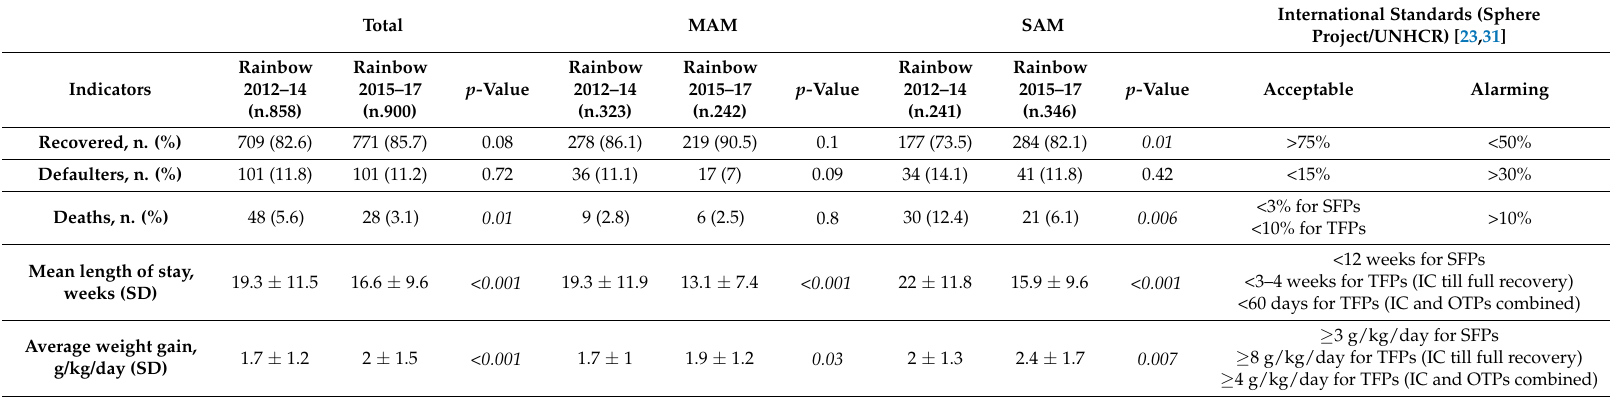
Table 2. The Rainbow 2012–14 vs. 2015–17 outcomes, and the International